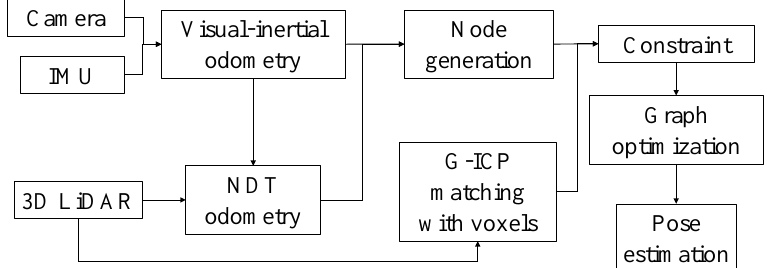
Figure 3. Overview of the proposed sensor fusion approach based on graph-based SLAM using a camera, an IMU, and a 3D LiDAR (Light Detection and Ranging). For node generation, both visual-inertial (VI) and normal distribution transform (NDT) odometry are used for robustness. Generalized iterative closest point (G-ICP) matching enables global